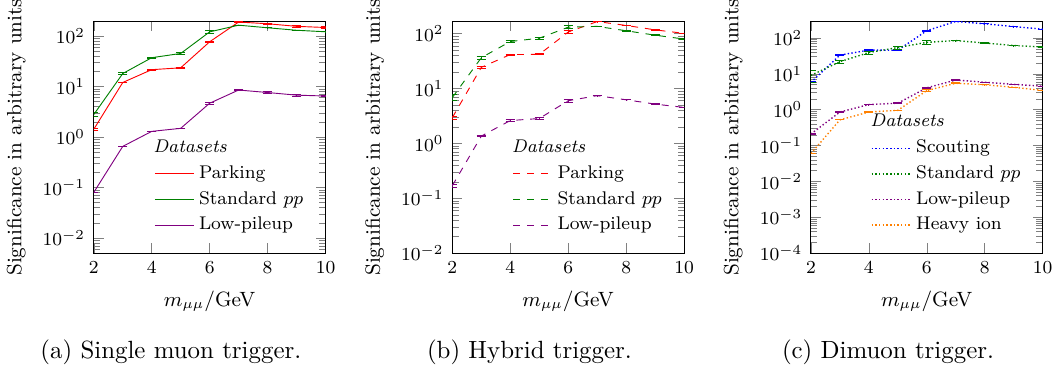
Figure 8 : Comparison of the significance to discover the displaced low- p as a function of the dimuon invariant mass. The comparison between the relevant datasets is shown for the single muon (a), hybrid (b), and dimuon (c) trigger scenarios during Run 3.